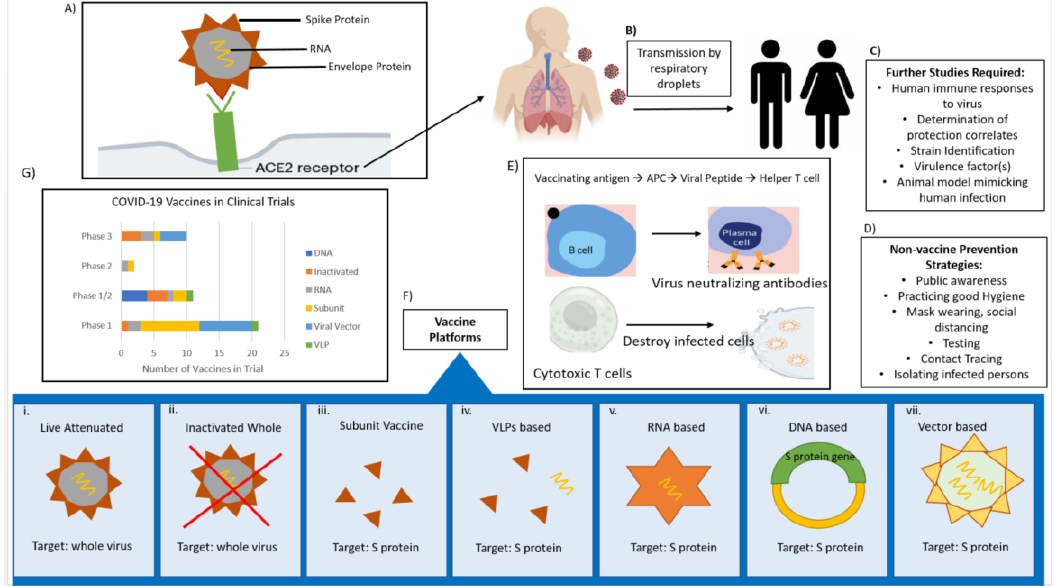
Figure 1. Portraying the biology of severe acute respiratory syndrome coronavirus 2 (SARS-CoV-2), mode of virus transmission, non-vaccine prevention strategies, and potential vaccine candidates that have progressed to clinical trials. ( A ) Viral structure and infection by binding of S protein to host receptor ACE2, ( B ) the transmission pathways, ( C ) identification of areas for further studies facilitating vaccine development, ( D ) non-vaccine strategies to contain the spread of infection, ( E ) potential vaccine may act through the production of neutralizing antibodies and/or cytotoxic CD8+ T cells that destroy the infected cells, ( F ) vaccine platforms for creating anti-SARS-CoV-2 vaccines, ( G ) number of potential vaccines entered into clinical trials.